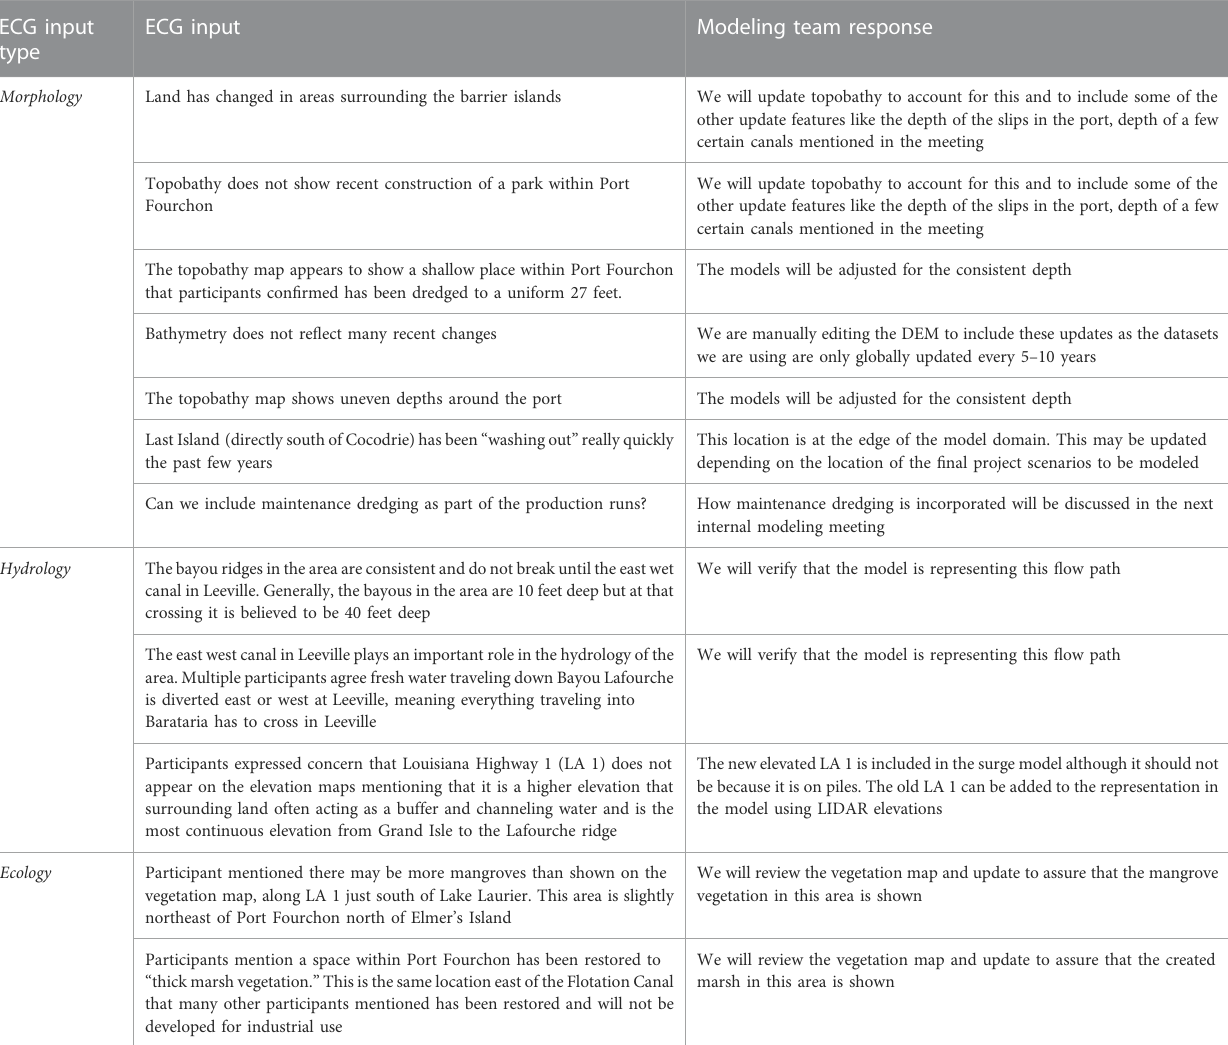
TABLE 2 ECG review of model